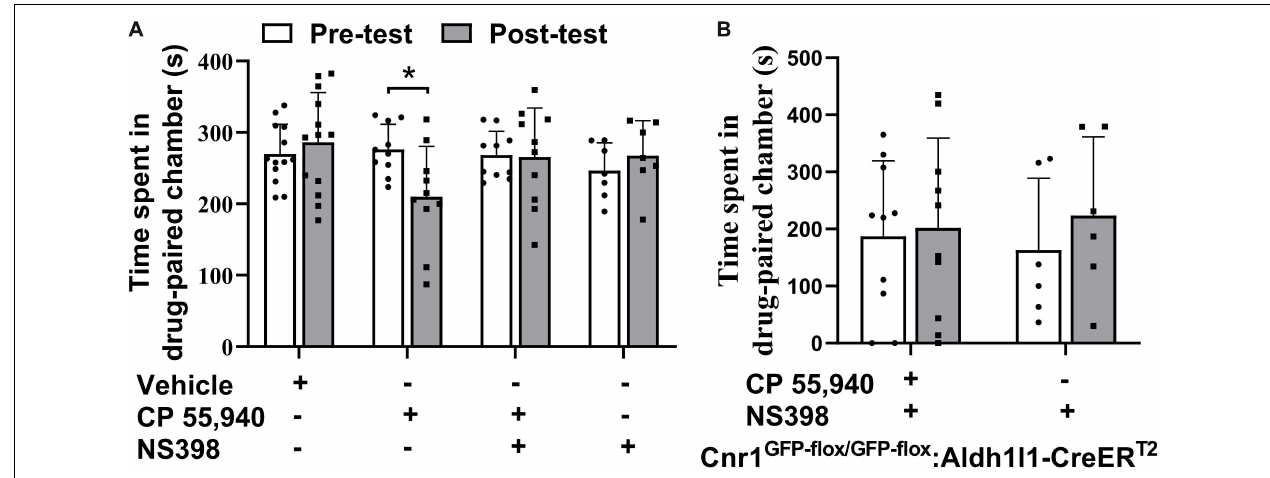
FIGURE 6 | Inhibition of cyclooxygenase-2 blocks conditioned place aversion induction by CP 55,940. (A) Statistical data showing that NS398 (specific cyclooxygenase-2 inhibitor, 10 mg/kg) does not induce conditional place preference, while it prevents conditioned place aversion (CPA) induction by CP 55,940 in Cnr1 + / + mice. NS398 is intraperitoneal injected 30 min before CP 55,940. (B) Statistical data showing that NS398 does not induce conditional place preference, while it prevents CPA induction by CP 55,940 in Cnr1 GFP - flox / GFP - flox : Aldh1l1 -CreER T2 mice treated with tamoxifen. * P < 0.05 (one-way